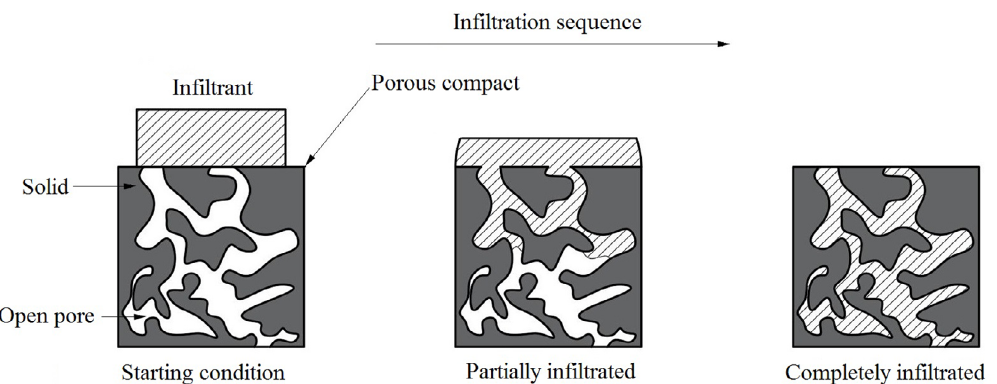
Figure 2. A sketch of the metallic infiltration process where capillary forces pull a metal melted into the open pores of a sintered compact 34 .